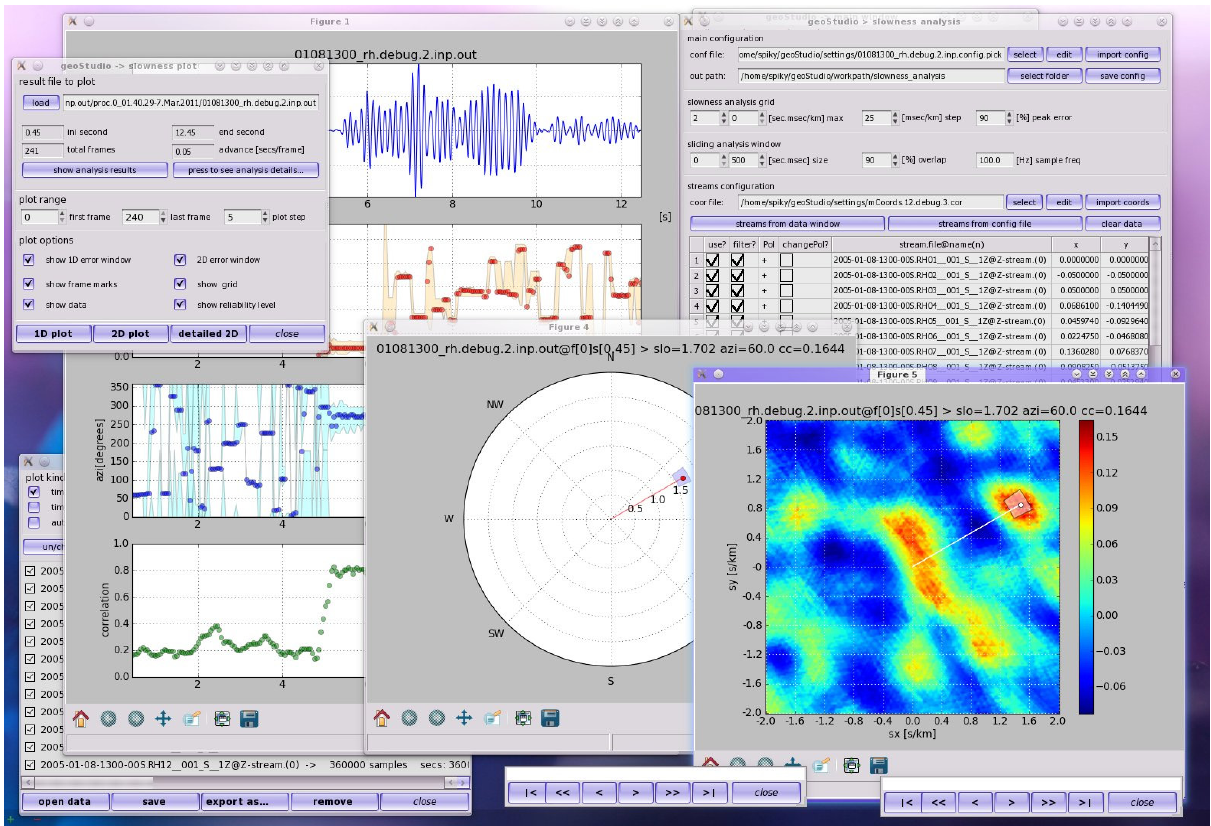
Figure 11. Screenshot of the software for the automatic estimate of the apparent slowness vector used for seismic array data running under the GeoStudio